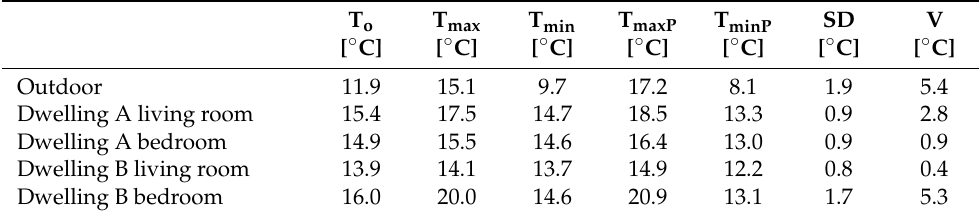
Figure 4. Monitored air temperatures. Table 4. Indoor and outdoor air temperature statistical variables for the monitored Table 5. Significant results from one-way ANOVA tests and post hoc Tukey’s HSD test.